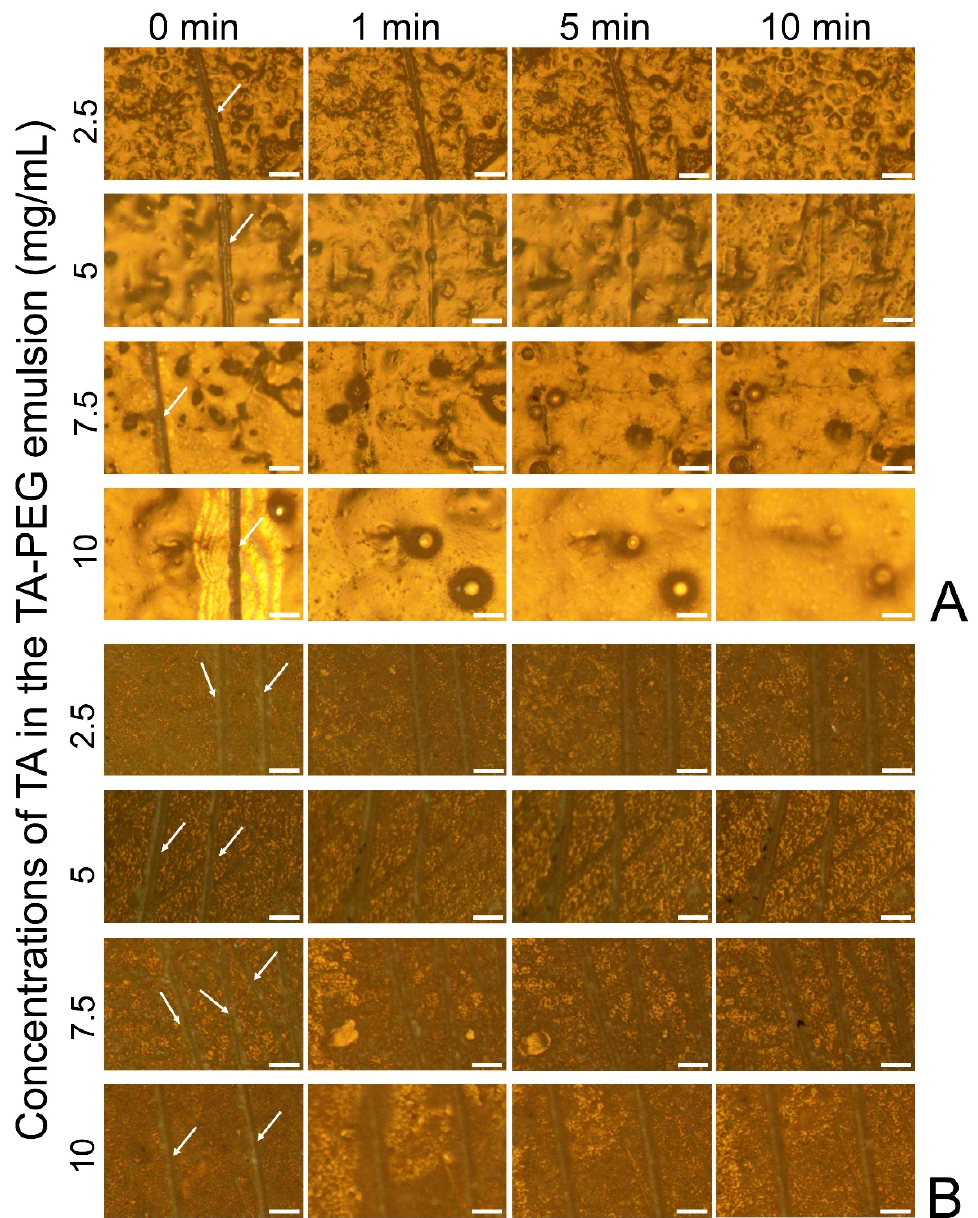
Figure 5. Optical micrographs showing the water-enabled healing behavior of the damaged coating layers obtained in 0 min, 1 min, 5 min, and 10 min from: ( A ) TA–PEG emulsions (5 mg/mL PEG with M W = 100 kDa; 2 M NaCl) containing different concentrations of TA (2.5 mg/mL, 5 mg/mL, 7.5 mg/mL, and 10 mg/mL). ( B ) TA–PEG emulsions (0.5 mg/mL PEG with M W = 200 kDa; 2 M NaCl) containing different concentrations of TA (2.5 mg/mL, 5 mg/mL, 7.5 mg/mL, and 10 mg/mL). The damages formed on the samples are marked by arrows. Scale bars represent 200 μ m.